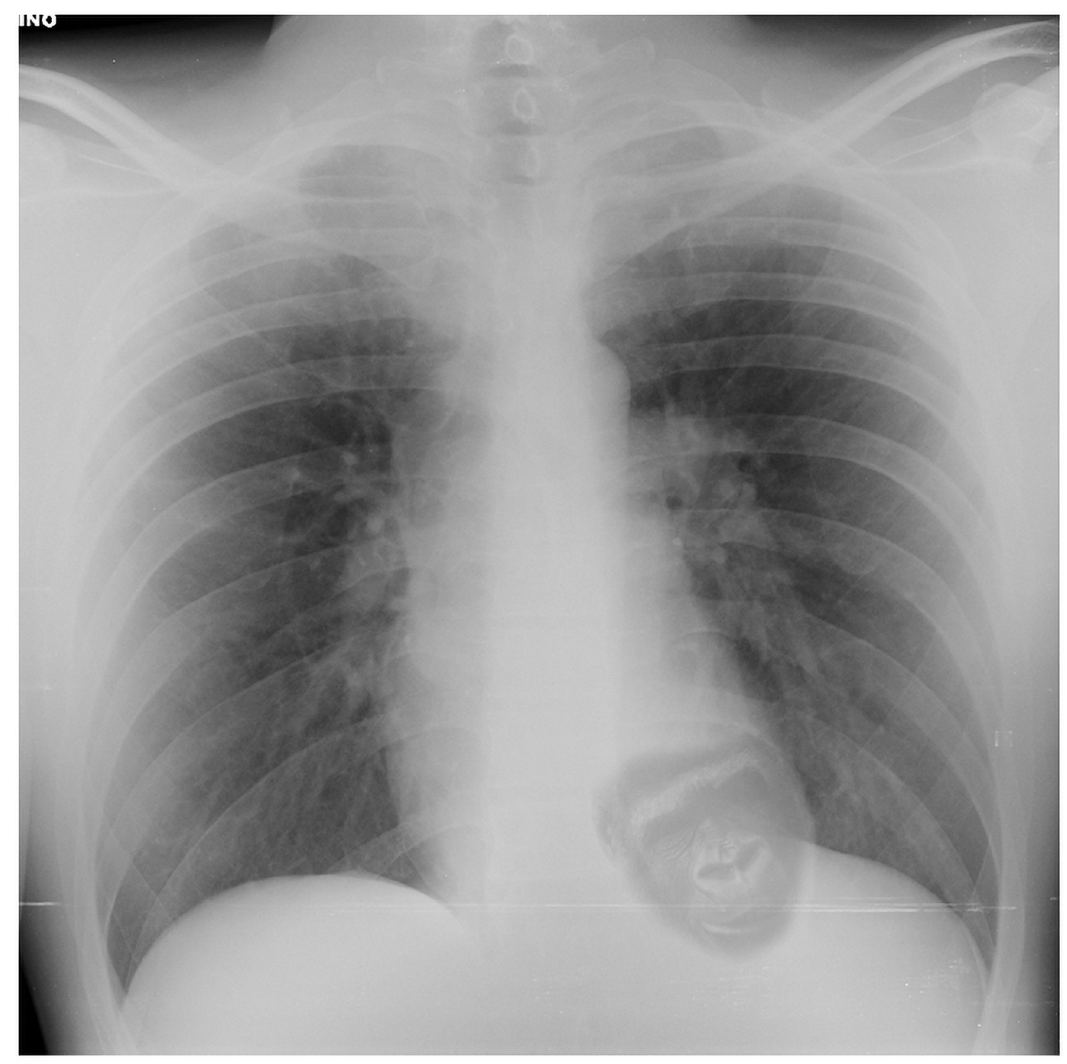
Fig 1. Chest radiography used in the survey with the embedded gorilla in the heart. The gorilla embedded in the heart is reprinted from https://commons.wikimedia.org/wiki/File:Female_Western_Lowland_Gorilla.jpg] and is of public domain. The figure is similar but not identical to the original image and is therefore for illustrative purposes